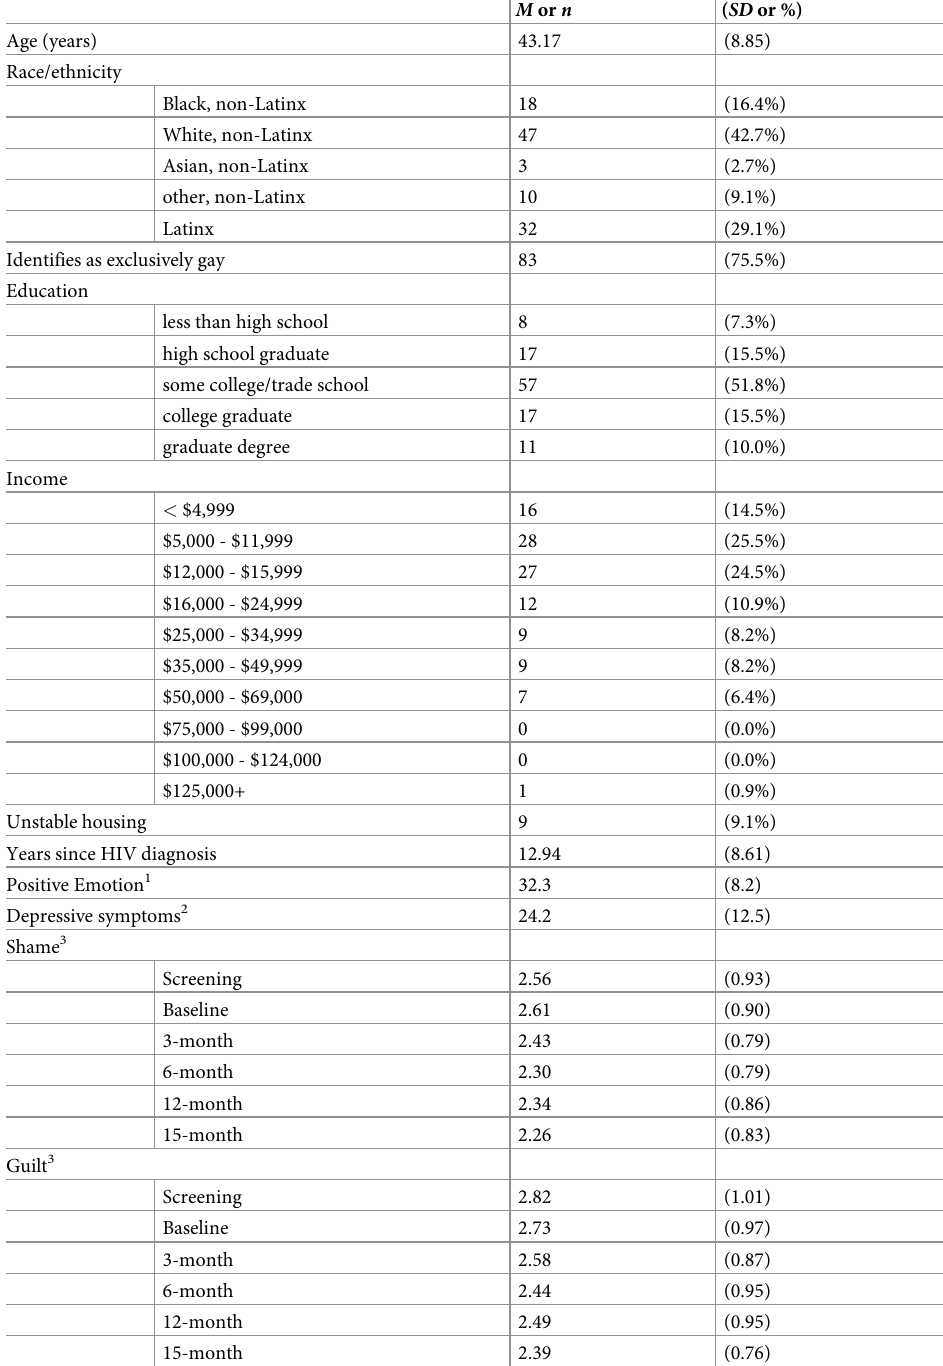
Table 1. Participant characteristics N =